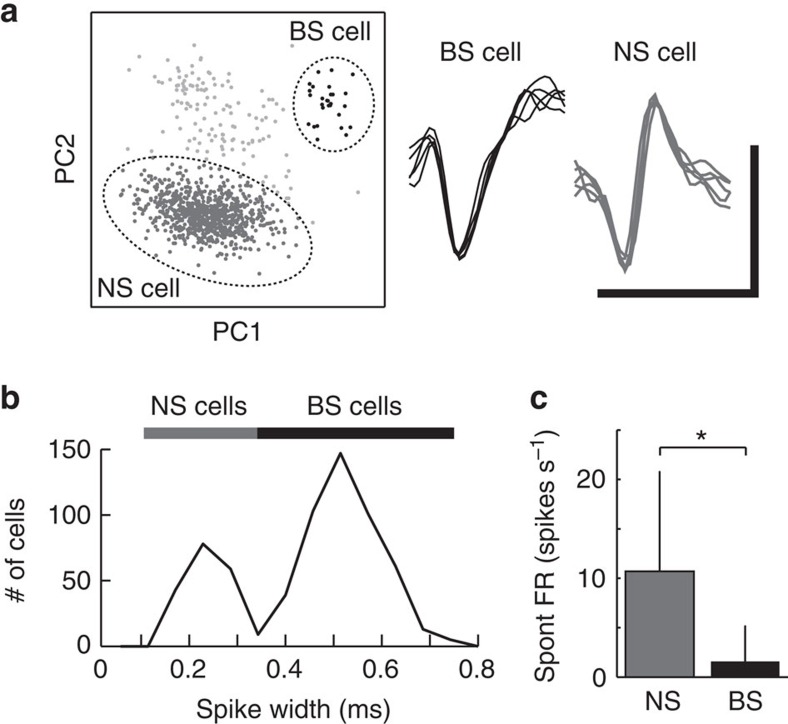
Two distinct neuron populations in the NCM.(a) A representative example of spike clusters and spike waveforms of
BS (broad spiking) and NS (narrow spiking) neurons. Scale bars, 1 ms
(horizontal), 0.2 mV (vertical). (b) Spike widths of NCM
neurons are bimodally distributed (n=658 neurons) BS neuron:
0.50±0.08 ms, n=469, NS neuron:
0.21±0.05 ms, n=189, (mean±s.d.),
Mann–Whitney U-test, P<0.001. (c) Spontaneous
firing rate (FR, spikes s−1) of NS and BS
neurons. Mean±s.d., n=189 and 469 for NS and BS
neurons, respectively, *P<0.001 by Mann–Whitney
U-test.